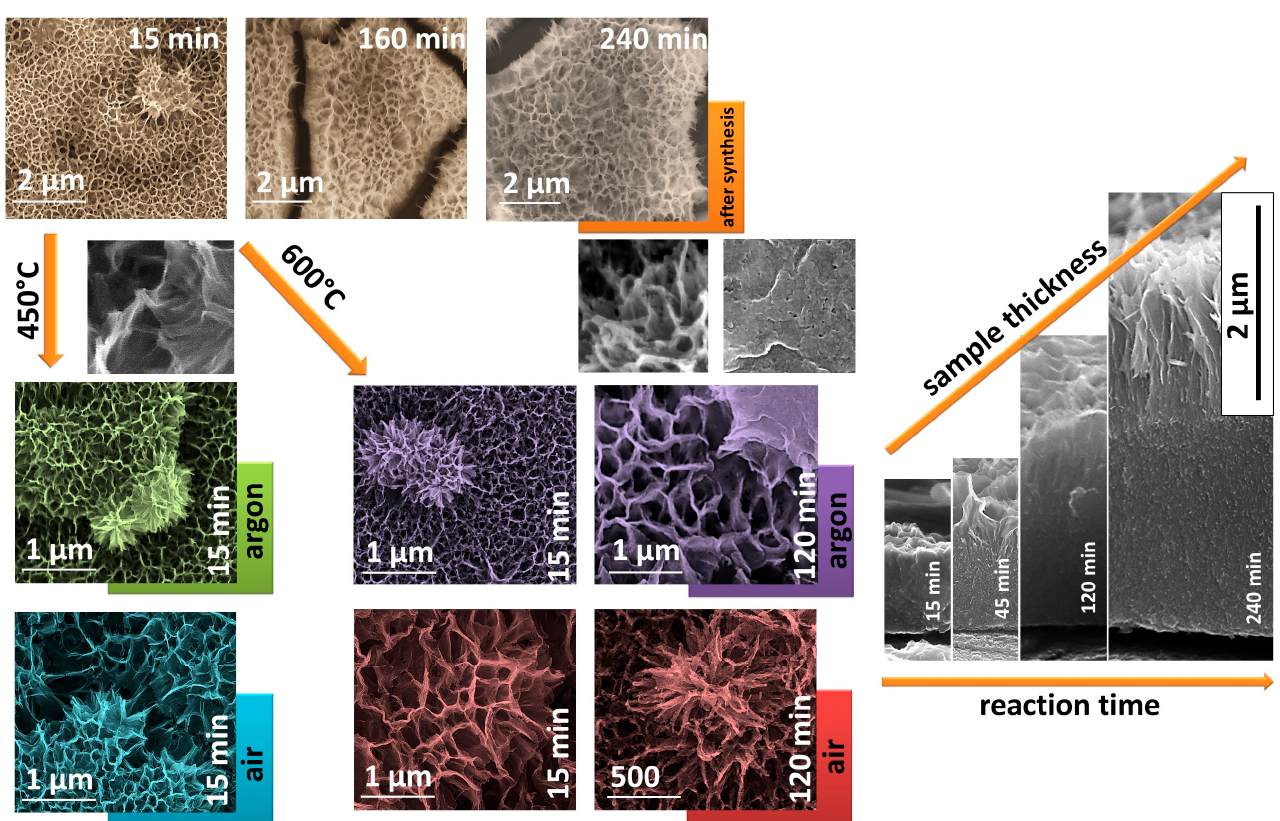
Figure 1. The surface and cross-section SEM images of obtained 3D flower-like titanium dioxide nanostructures. Table 2. Structural features of flower-like 3D nanostructures.